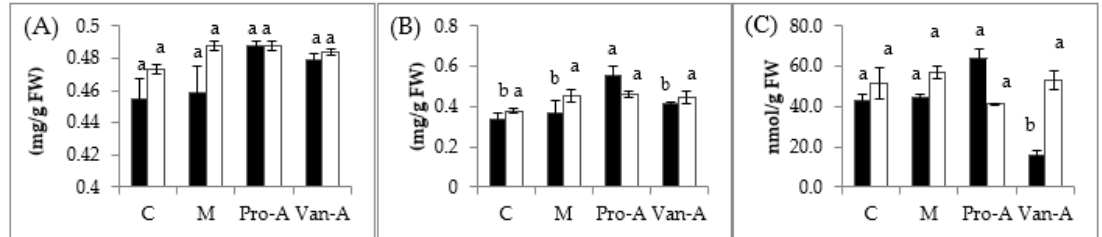
Figure 1. Changes of: chlorophyll a ( A ); chlorophyll b ( B ); and MDA ( C ) contents of rice after pre-treatment with PA and VA. Black column (three days after submergence) and white column (six days after submergence); C: Control, M: Mixture, Pro-A: Protocatechuic acid, Van-A: Vanillic acid; Means with different small letters in the same column color are significantly different ( p < 0.05); FW: Fresh weight; MDA: malondialdehyde.